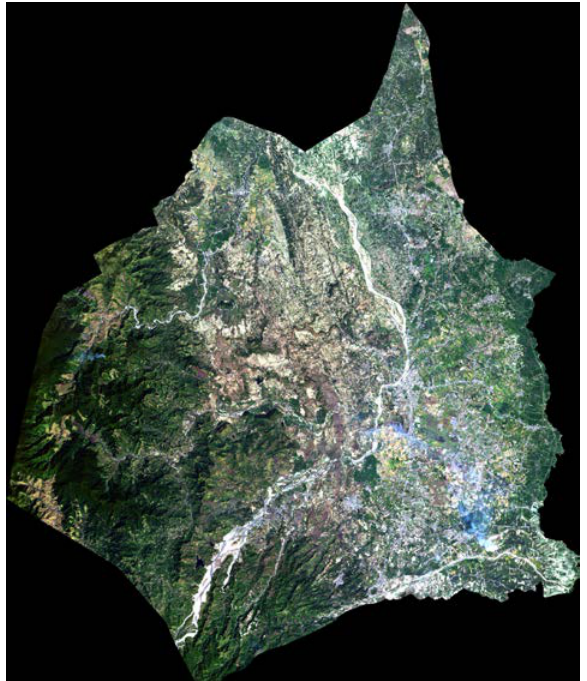
Figure 1. Landsat 8 Operational Land Imager (OLI) satellite image (February 13, 2016) of Tarlac,